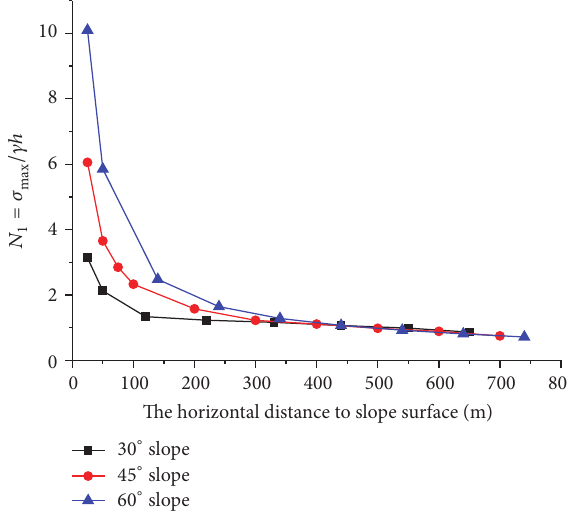
Figure 5: Variation curves of the maximum principal stress at the elevation of 100m in different slope angles only considering the gravity stress.